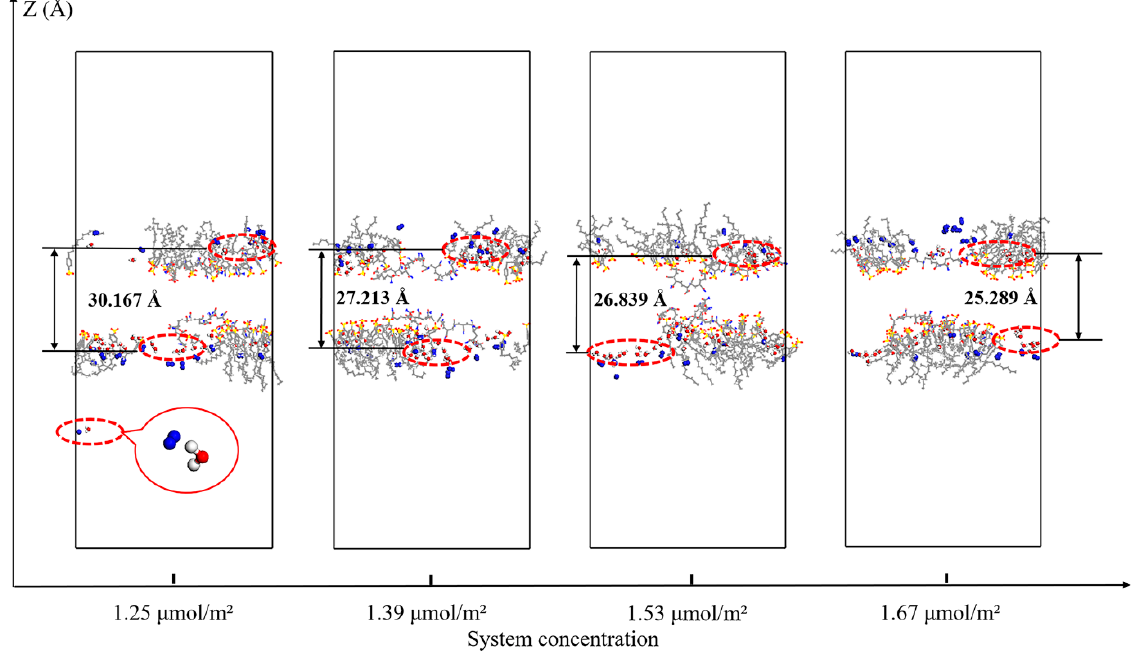
Figure 17. Snapshots of the gas–liquid interface in foam systems with different SDBS concentrations after dynamic relaxation equilibrium. Polymers 2023 , 15 , 584